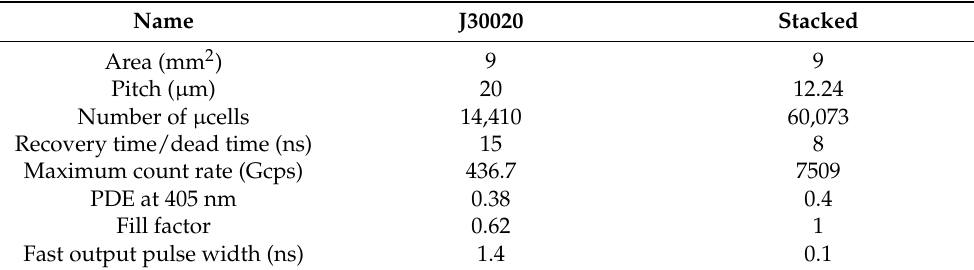
Table 4. Comparison between a J30020 and a potential stacked SPAD